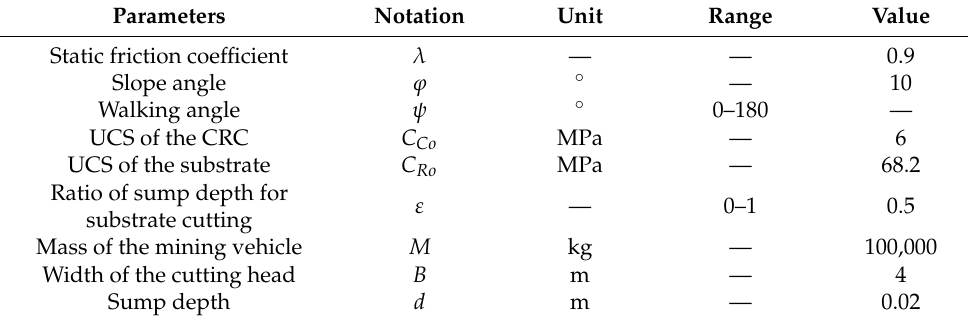
Table 4. Parameters for the stability